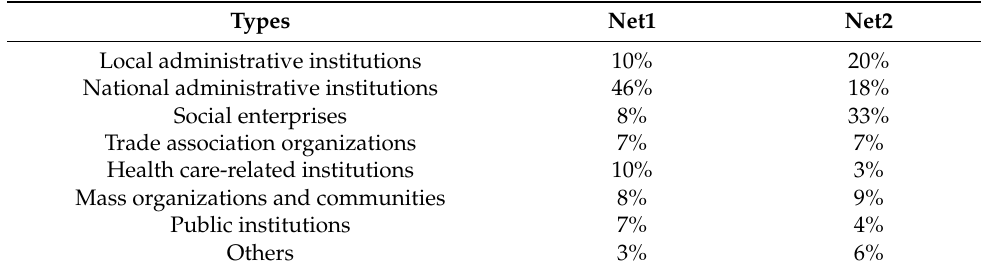
Table 3. Organizational types for emergency supply support and their proportions.